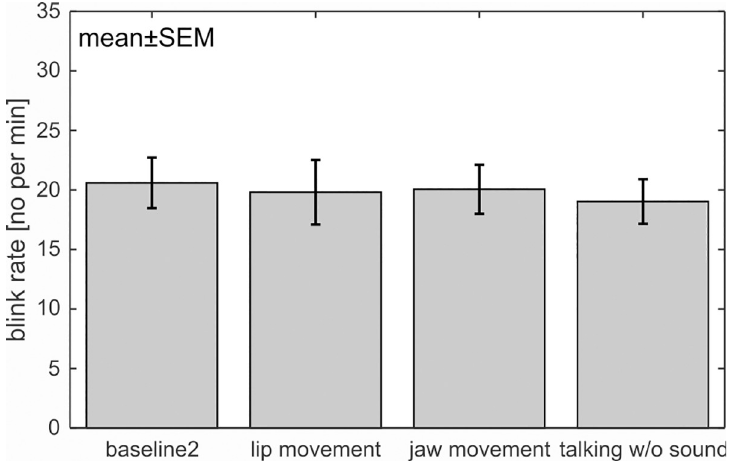
‘Add 1’ task, which did not increase the blink rate.